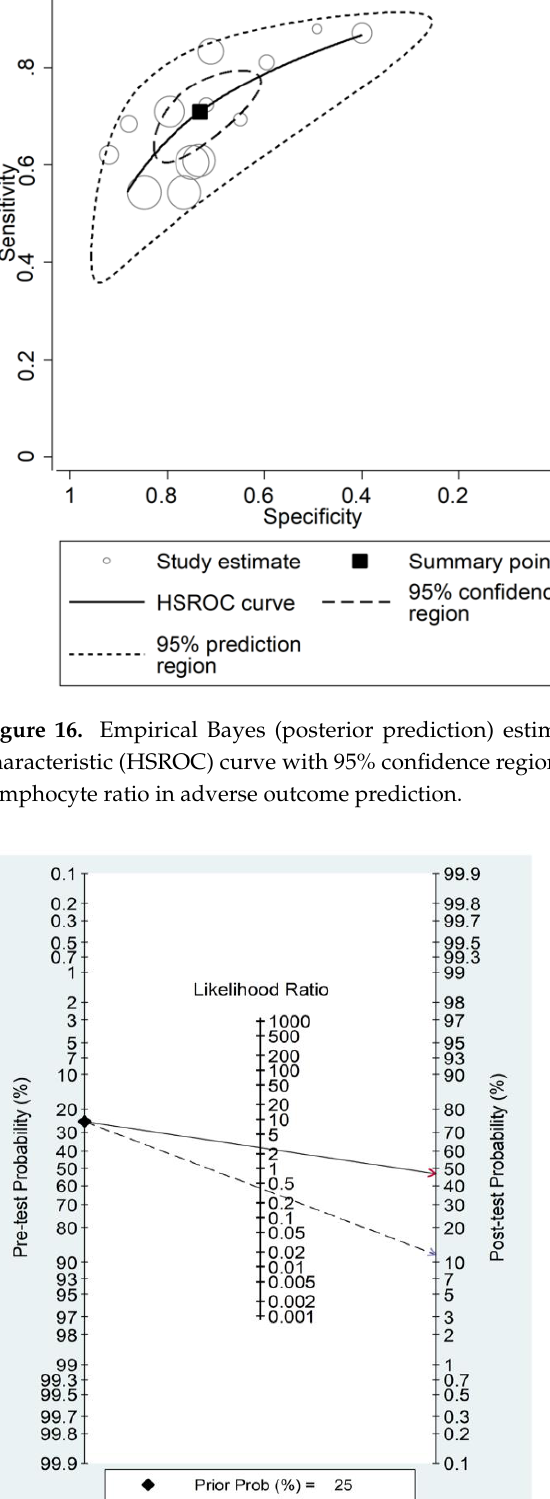
Figure 15. SROC curve with 95% confidence region and prediction region for neutrophil-to-lym- phocyte ratio and adverse outcome prediction.